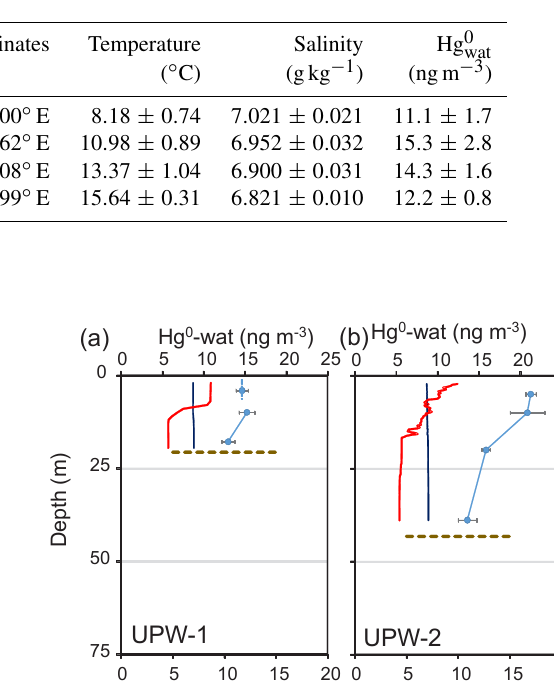
Table 2. Upwelling study conducted near Øland Island (Sweden) in August 2015. The station names, date and time of sampling, and the locations of the sampling sites are shown. The mean surface water temperature, salinity, and Hg 0 wat concentration together with the corresponding standard deviation are reported.